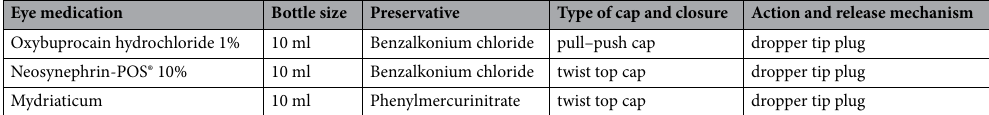
Table 2. Overview of examined multi-dose eyedrop bottles with respective eye medication, bottle size, preservative, type of cap and closure, and action and release